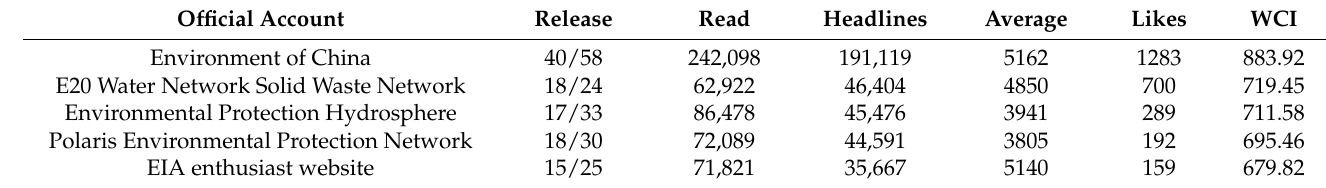
Table 5. Weekly list of WeChat WCI index of environmental education in the top five